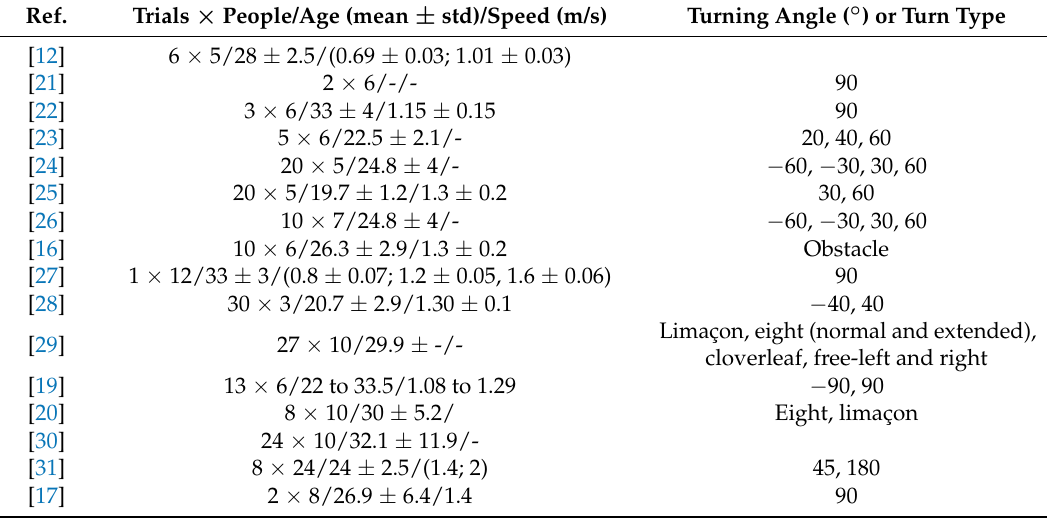
Table 2. Experimental conditions used in the studies based on optical motion capture systems.